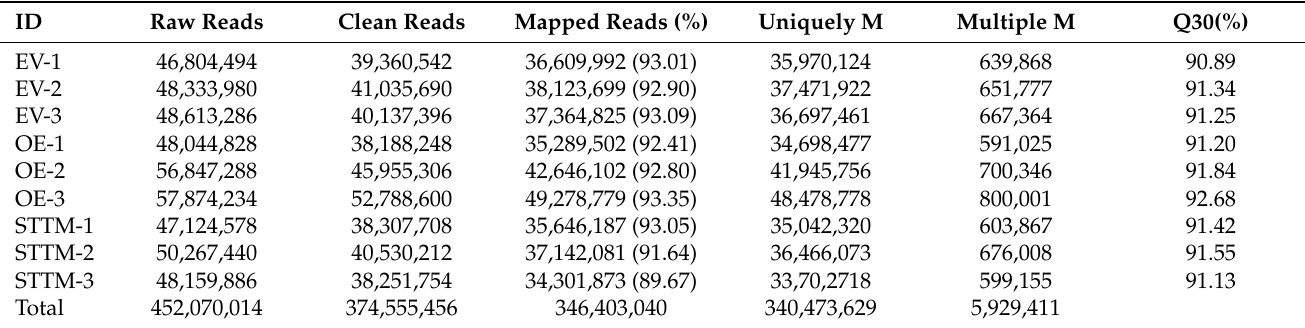
Table 3. The raw reads and clean reads obtained in 9 small RNA libraries.